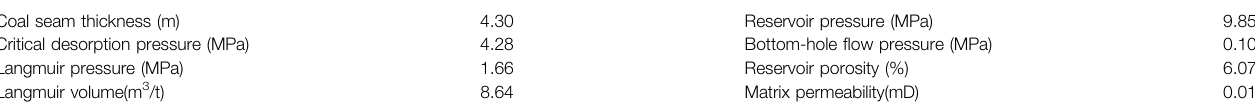
TABLE 1 | Reservoir parameters of well Ma 26 in No. 15 coal seam of the Mabidong block.